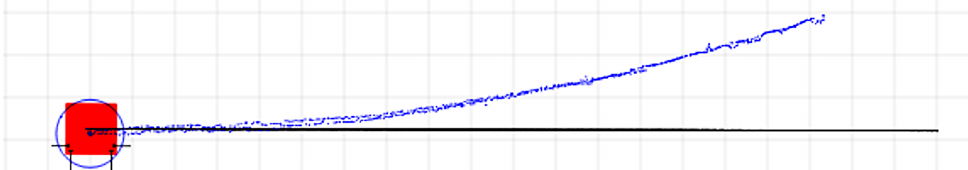
Figure 12. Lateral translation correction factors determination by the IPS (translation, left- translation–rotation, and right-translation–rotation).